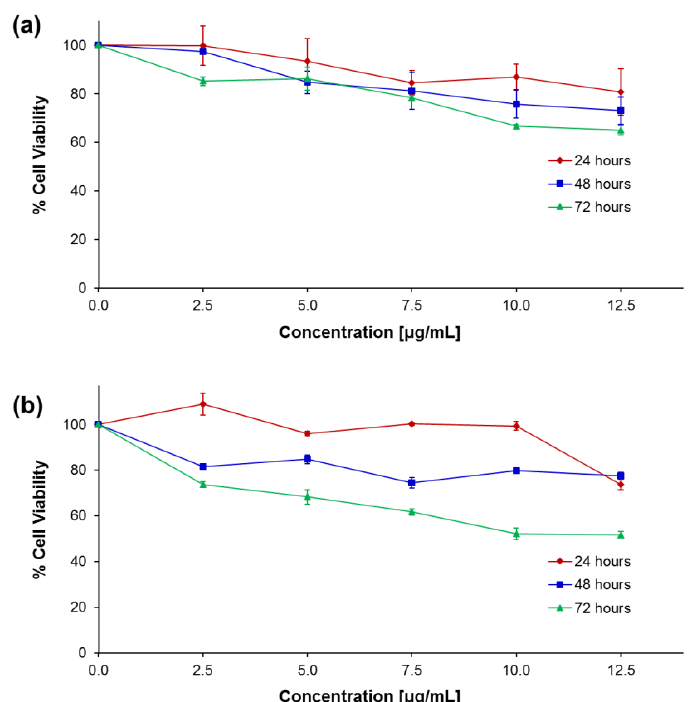
Figure 4. The effect of rmIL-10-conjugated Ag-PVPs ( a ) and non-conjugated Ag-PVPs ( b ) on cellular viability. Mouse J774 macrophages were exposed to Ag-PVPs or rmIL-10-conjugated Ag-PVPs for 24, 48, and 72 h and the cell viability was determined by the tetrazolium dye MTT (3-(4,5-dimethylthiazol-2-yl)-2,5-diphenyltetrazolium bromide) based assay. The relative survival of cells is expressed as the percent of control untreated cells.